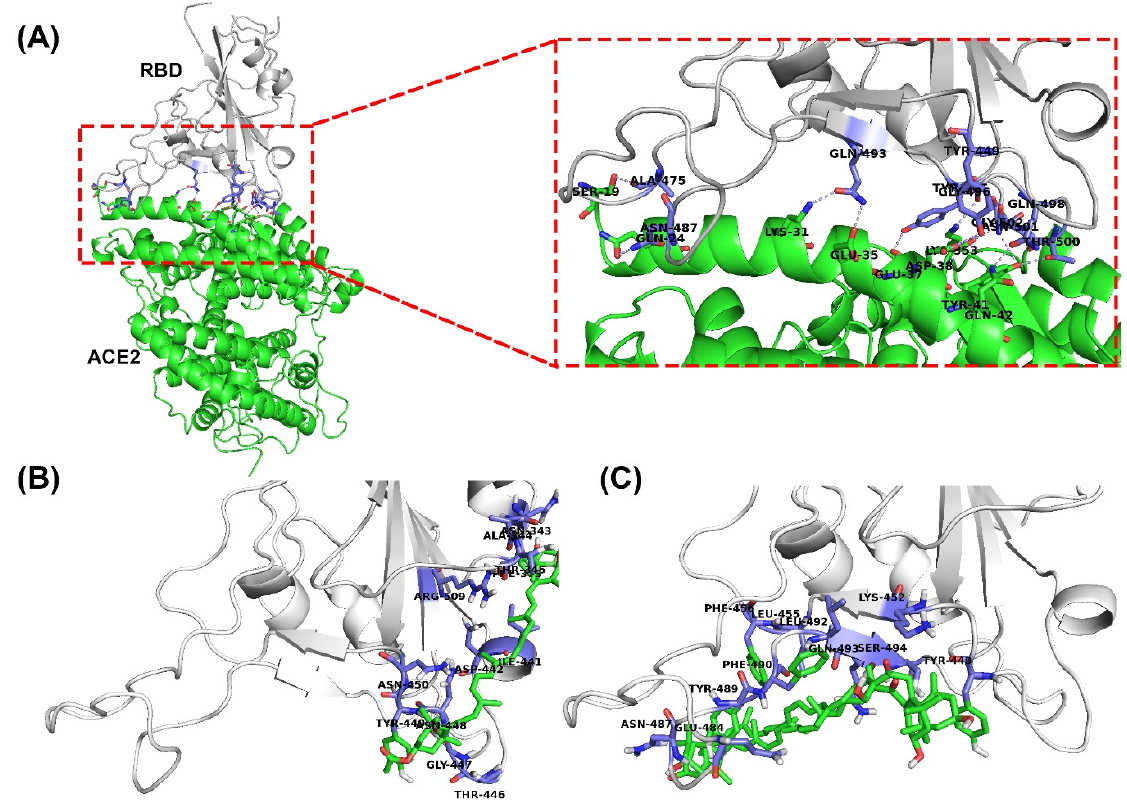
Figure 1. Surface and cartoon representations of structures of ( A ) the SARS-CoV-2 chimeric receptor-binding domain (RBD) complexed with angiotensin-converting enzyme 2 (ACE2). The molecular docking poses of ( B ) fucoxanthin and ( C ) siphonaxanthin interacting with RBD (PDB:6vw1) analyzed with AutoDock Vina. The tertiary structures of RBD-ligands were made with PyMOL. Ligands and ACE2 are depicted as green sticks and green cartoons, and the binding site residues are labeled accordingly.